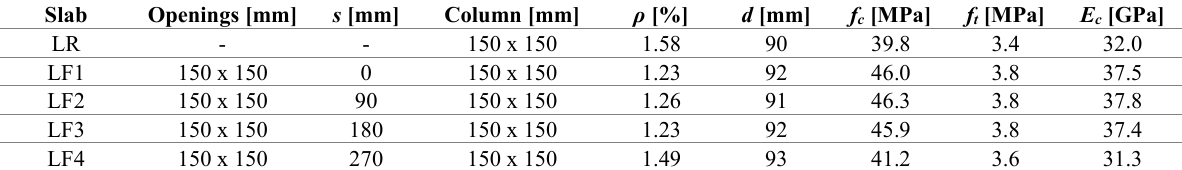
Table 1. Properties of